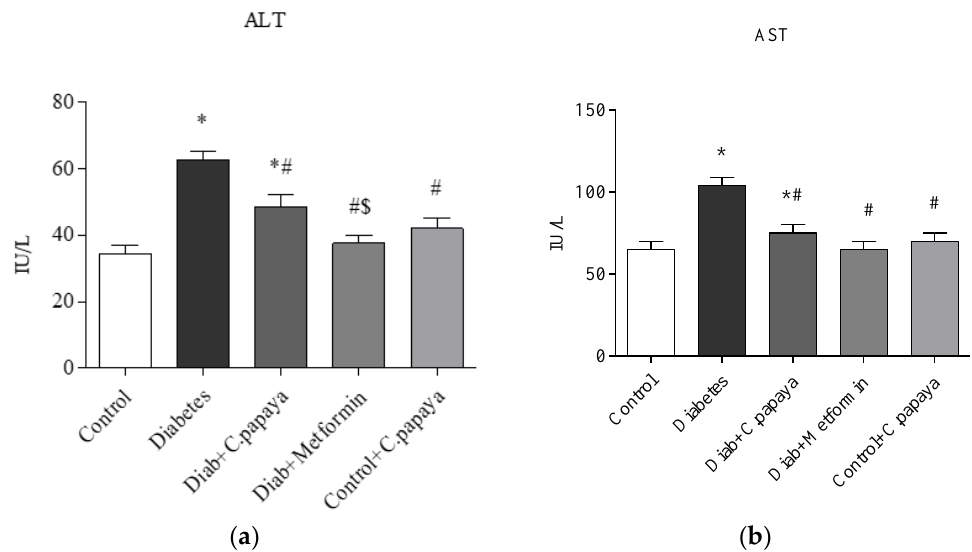
Figure 1. ( a , b ) Effect of C. papaya on ( a ) ALT and ( b ) AST levels. p < 0.05 was considered statistically significant among the groups: *-control; #-diabetes; $- C. papaya -treated T2DM.